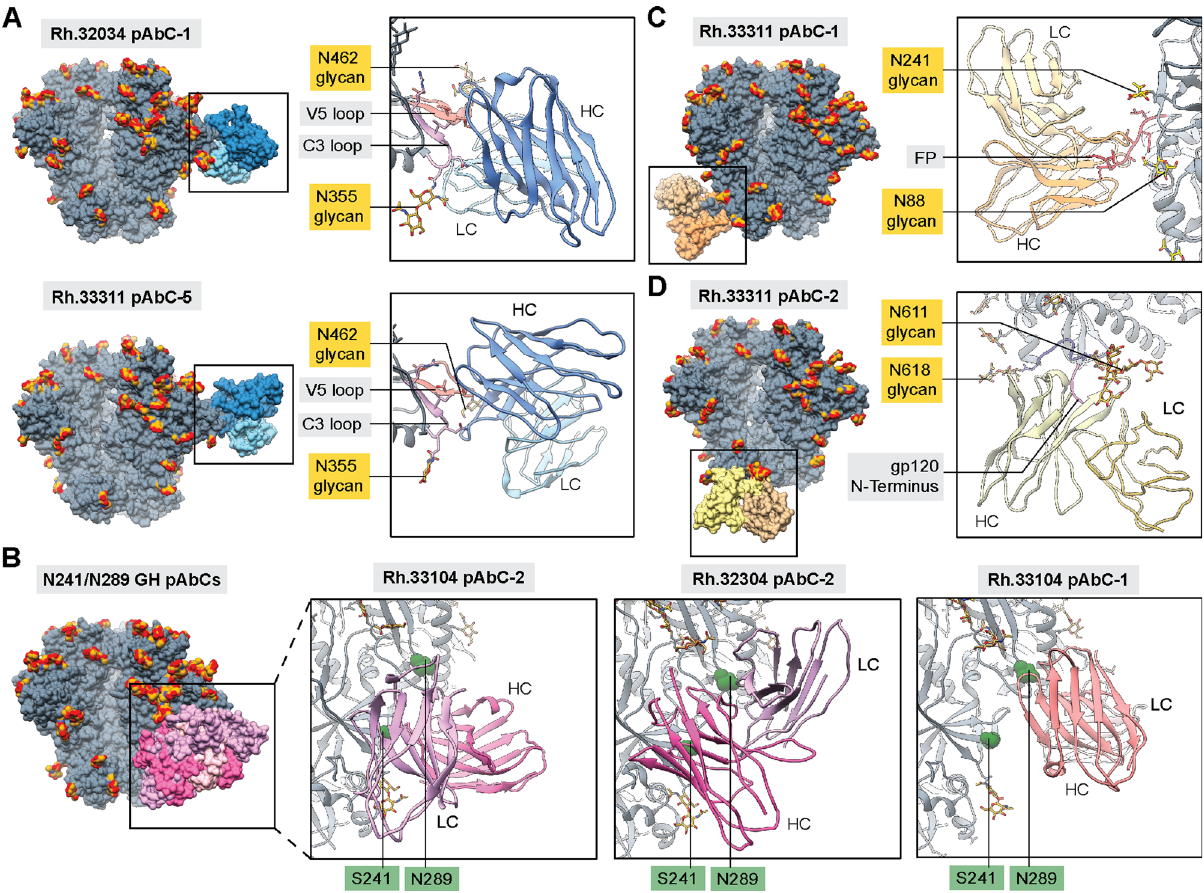
Fig. 3 Structural analysis of neutralizing and potentially neutralizing antibody responses. Structures of BG505 SOSIP antigens in complex with polyclonal antibodies targeting C3/V5 ( A ), N241/N289 glycan hole ( B ), fusion peptide ( C ), and N611 glycan epitopes ( D ). BG505 SOSIP trimers are shown in gray with N-linked glycans in golden yellow. Antibodies are colored using the same scheme as in Figs. 1 and 2. Inferred heavy and light chains for each antibody are represented in different shades and labeled in each panel (HC and LC, respectively). The most relevant epitope/paratope components are indicated in the supporting panels. Surface representation is used for the full immune complex (left side of each panel) while ribbon and stick representations are used for the display of epitope-paratope contacts (right side of each panel). In panel B , sphere representations are used for residues S241 and N289 to improve